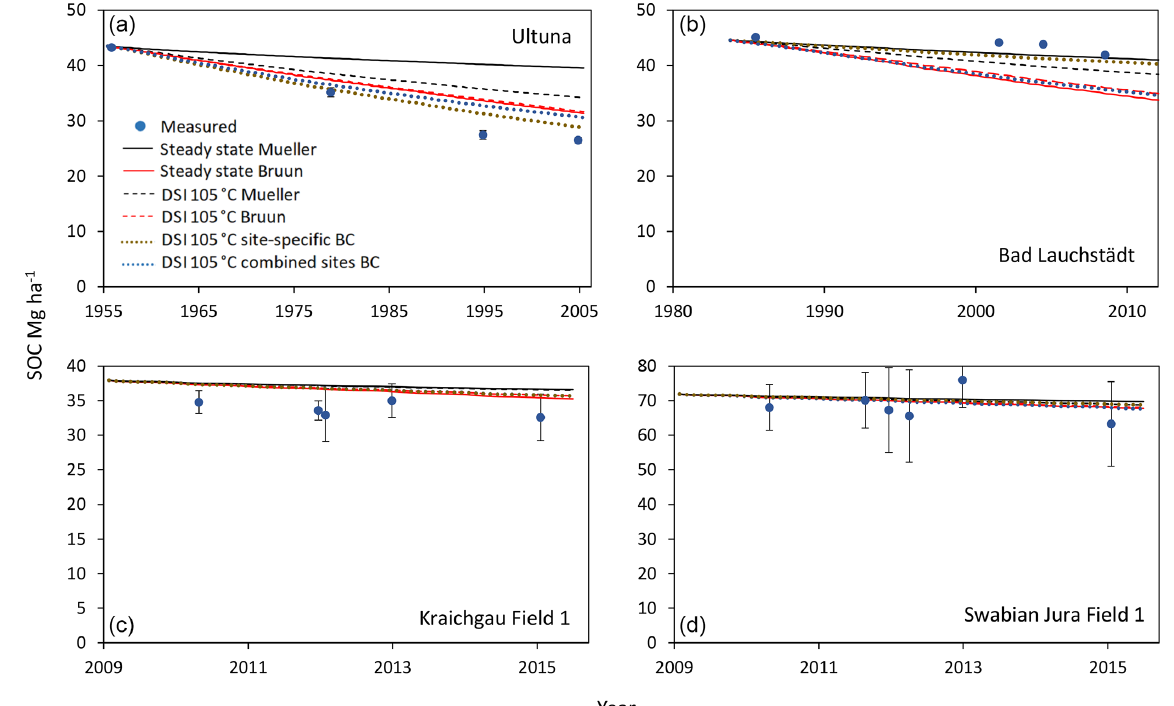
Figure 3. Example of SOC simulations from Ultuna (a) , Bad Lauchstädt (b) , Kraichgau Field 1 (c) and Swabian Jura Field 1 (d) . Initializa- tions were carried out (i) assuming a steady state using the formula of Bruun and Jensen (2002) (Eq. 1) with turnover rates of both Mueller et al. (1997) and Bruun et al. (2003) and (ii) by the DRIFTS stability index (DSI) at a 105 ◦ C drying temperature using both turnover rates for simulations (simulations using the other drying temperatures for the DSI are in the supplementary material). The site-specific and the combined-sites Bayesian calibrations (BC) are also displayed. Bars indicate the standard deviation of measured values of all plots ( n = 3) per field.